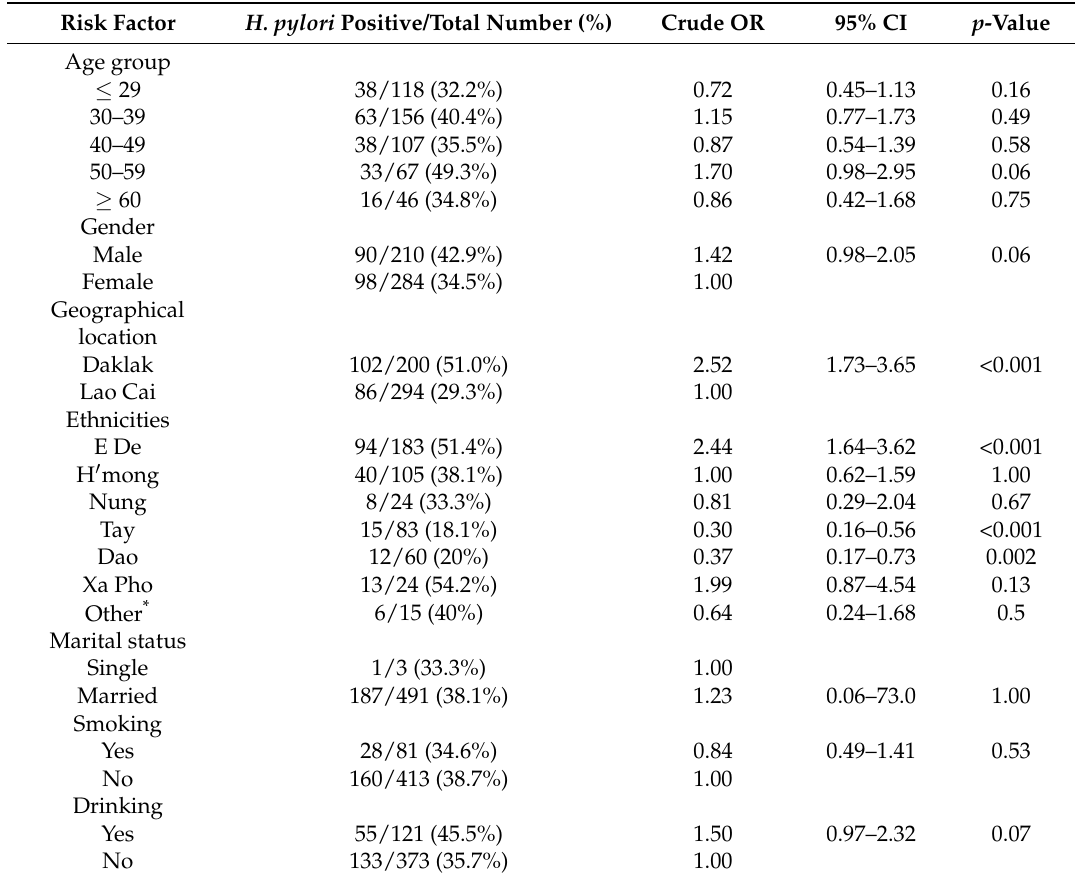
Table 2. Risk factors of H. pylori infection in the study